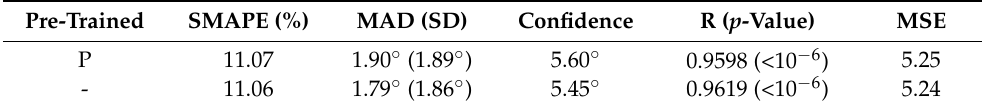
Table 5. Comparison of the model with and without the pre-training model.